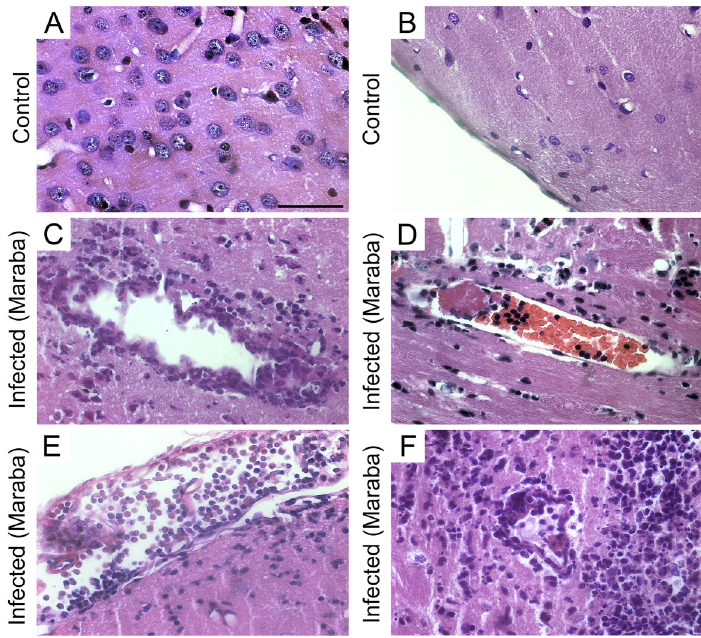
Figure 1 . Photomicrographs of control ( A and B ) and infected mouse ( C to F ) sections, at 6 dpi (days post-infection), stained with hematoxylin/eosin. A , Hippocampal region and B , parietal cortex of control animal with normal pia mater; C , cortical area with perivascular in fl ammatory in fi ltrates with an extensive area of edema; D , cortical parenchyma; E , pia mater of the entorhinal cortex with in fl ammatory in fi ltrate; F , periventricular area with in fl ammatory in fi ltrate near the subependymal cell layer. Scale bar: 30 m